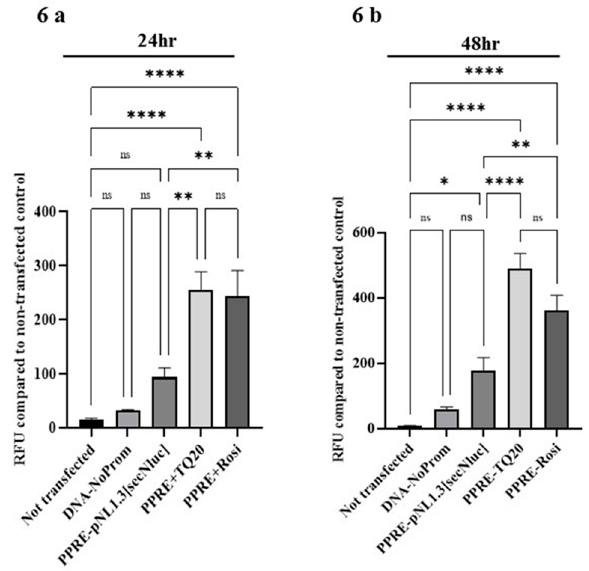
Figure 6. Effect of TQ on PPRE-pNL1.3[secNluc] plasmid containing PPAR- γ transcription factor promoter activity. The full-length sequence of PPAR- γ was cloned into PPRE-pNL1.3[secNluc] plasmid transfected using lipofectamine LTX in HT-29 cells. Luciferase expression at 24 and 48 h was determined in 50 µ L supernatant culture media luminometrically. TQ treatment (20 µ M) significantly increased luciferase expression in PPRE-pNL1.3 transfected HT-29 cells time-dependently (24 h ( a ), 48 h ( b )). Rosiglitazone (PPAR- γ agonist, 10 μ M) used as a positive control. The luciferase expression was compared to non-transfected controls. n = 4 separate experiments used for obtaining the data for PPAR- γ promoter activity studies. The data expressed as means ± SEM. ≤ 0.05 considered statistically significant. **** p < 0.0001 , *** p < 0.001 , ** p < 0.01 , and * p < 0.05 . (NS) not significant.